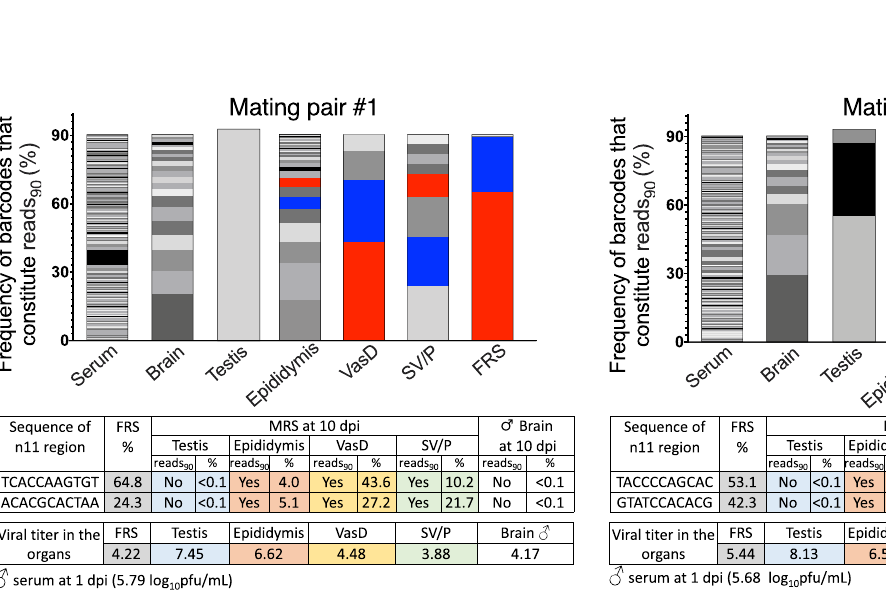
Fig. 5 Construction and application of a library of ZIKV genomes with unique molecular identi fi ers (barcodes). a Construction of a barcoded library of ZIKV genomes using genetic background of 2 × scr virus. Green boxes and letters indicate scr sequences. Red letters highlight a stretch of 11 random nucleotides. b Experimental design of a semen shedding study using AG129 mice infected with a barcoded ZIKV library. c Hypothetical reduction of barcoded virus diversity during hematogenous dissemination of the ZIKV-lib/n11 and shedding of the viruses into FRS with ejaculate. d Mean number of barcodes in the reads 90 ± SD of ZIKV-lib/n11 virus population isolated from: mouse serum at 1 dpi ( n = 7); mouse organs at 10 – 11 dpi ( n = 7); or from the inoculum that was used for mouse infection ( n = 1). Difference between the number of barcodes in reads 90 in the serum and mouse organs was compared using one-way ANOVA with multiple comparison adjustment (Dunnett ’ s test). e , f Mean combined frequencies of common barcodes (CFCB) among reads 90 (%) ± SD for ZIKV-lib/n11 viruses recovered from the testis ( e ) or epididymis ( f ) and various organs of AG129 male mice ( n = 7). Differences between common barcode frequencies among organ pairs were compared using one-way ANOVA with multiple comparison adjustment (Tuke ’ s test). **** p < 0.0001.